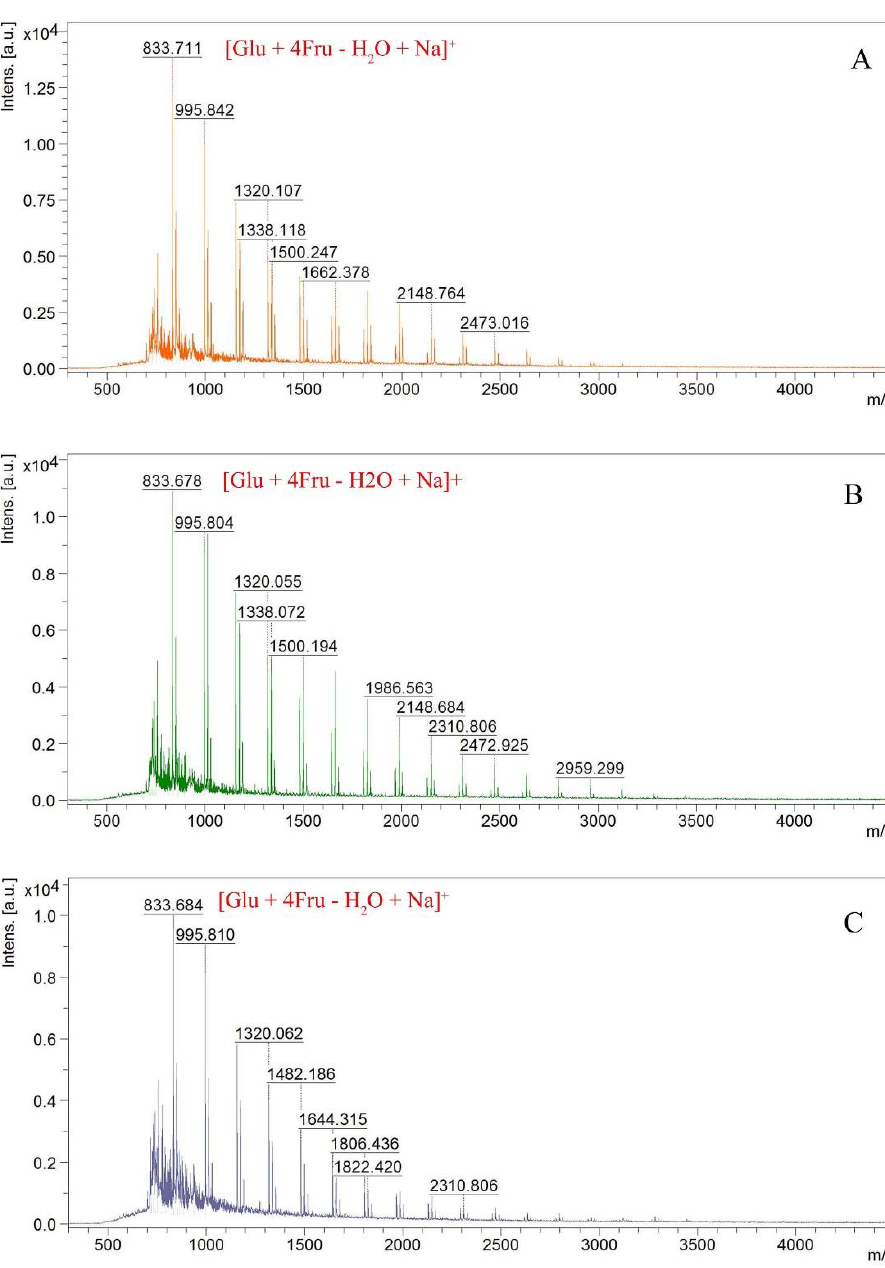
Figure 5. MALDI-TOF mass spectra of fructan 1 ( A ), 2 ( B ) and 3 ( C ).